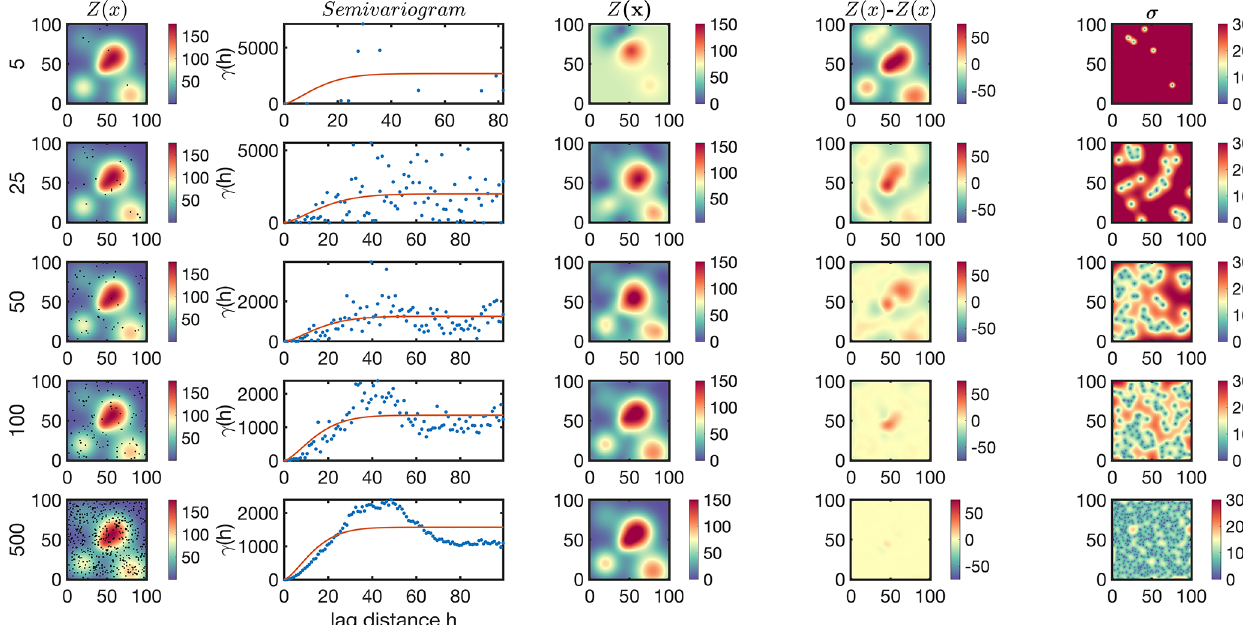
Figure 2. First column: the multi-plume case (C5) randomly sampled with a different number of samples (5, 25, 50, 100, and 500); second column: the corresponding isotropic semivariogram; third column: the kriging estimate; fourth column: the difference between the estimate and the truth; and fifth column: the kriging standard error.